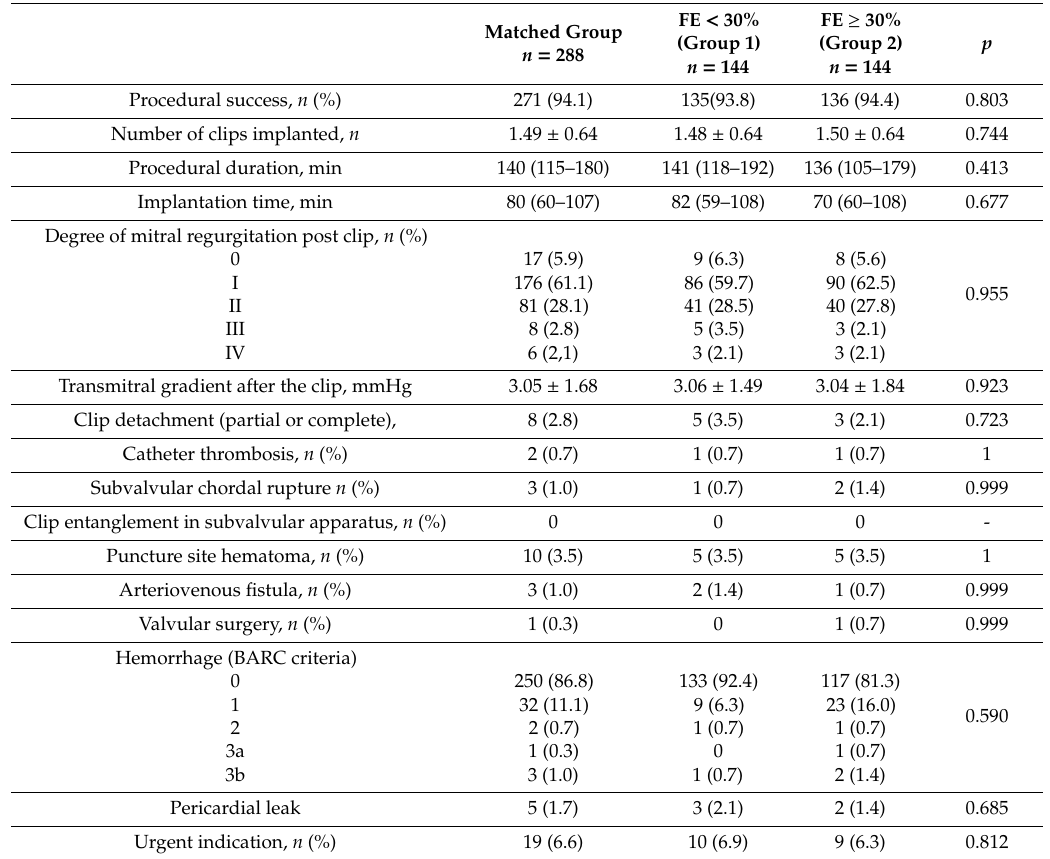
Table 3. Procedure-related